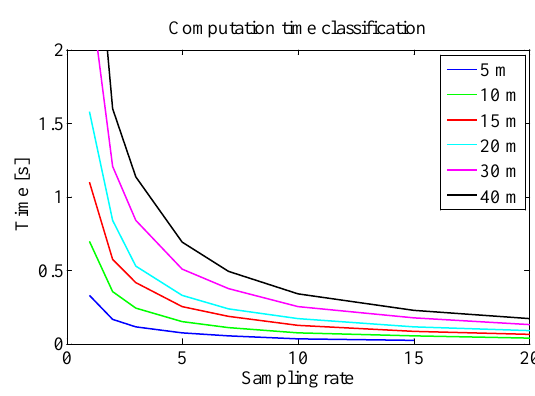
Figure 16: Computation time of the correlation analyses at various sampling rates and lengths of processed scan segments at a resolution of 0.01 m.